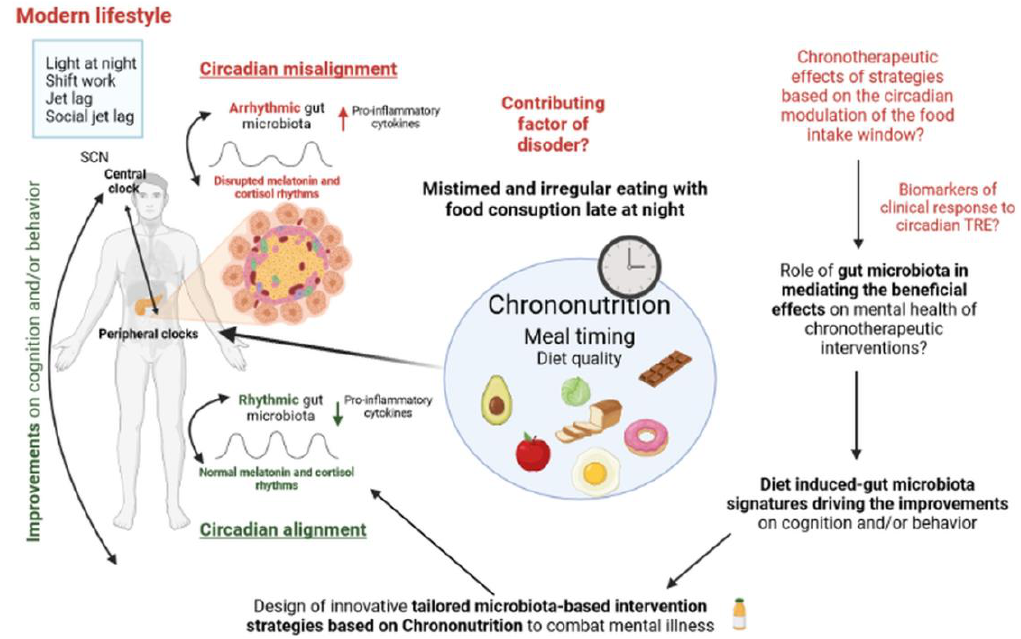
Figure 5. Potential prevention or restoration of circadian misalignment through microbiome-based and dietary strategies founded on chrononutrition. Food intake is a major driver of circadian rhythmicity in microbiome composition and function, and unhealthy meal habits, such as irregular and mistimed eating patterns commonly observed in subjects with mental disorders, could possibly contribute via changes in gut microbiota to psychiatric symptoms and metabolic disturbances. Aligning the eating schedule with the circadian rhythms may prevent the development of mental health disorders in susceptible subjects or improve the clinical symptoms in psychiatric patients via the modulation of intestinal ecology. The elucidation of the altered microbiome chronobiology linked to mental disorders and the role of chrononutrition in the restoration of the healthy microbiome chronobiology may pave the way for highly innovative novel preventive and therapeutic approaches. TRE: Time-restricted eating.